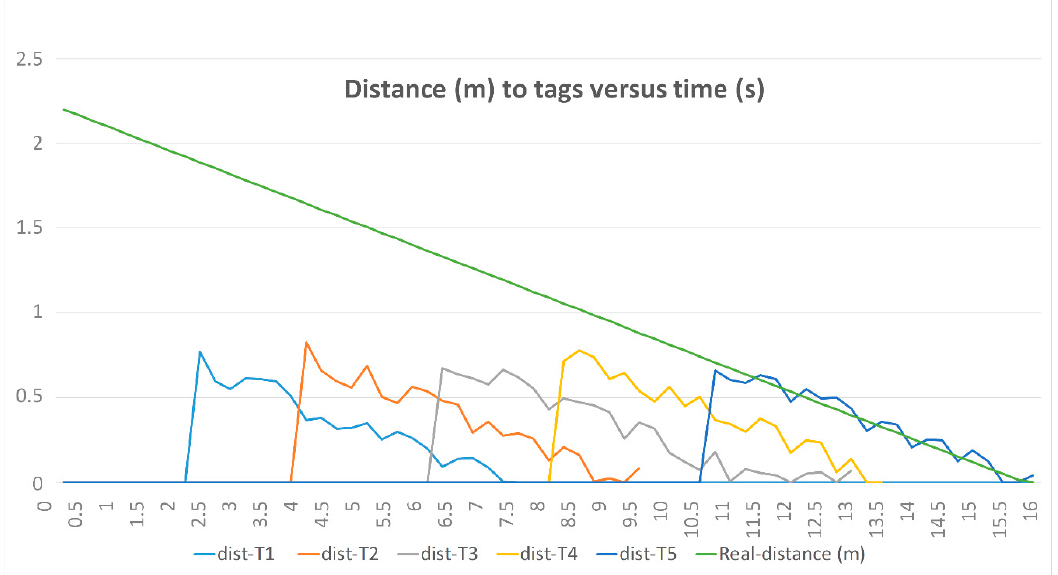
Figure 16. Distance to tags as reader traverses perimetral corridor.